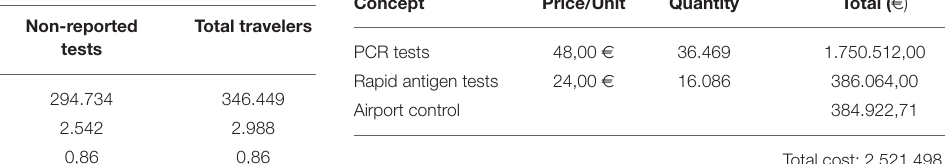
TABLE 3 | Total number of tests performed by the laboratories and the number of positive cases.